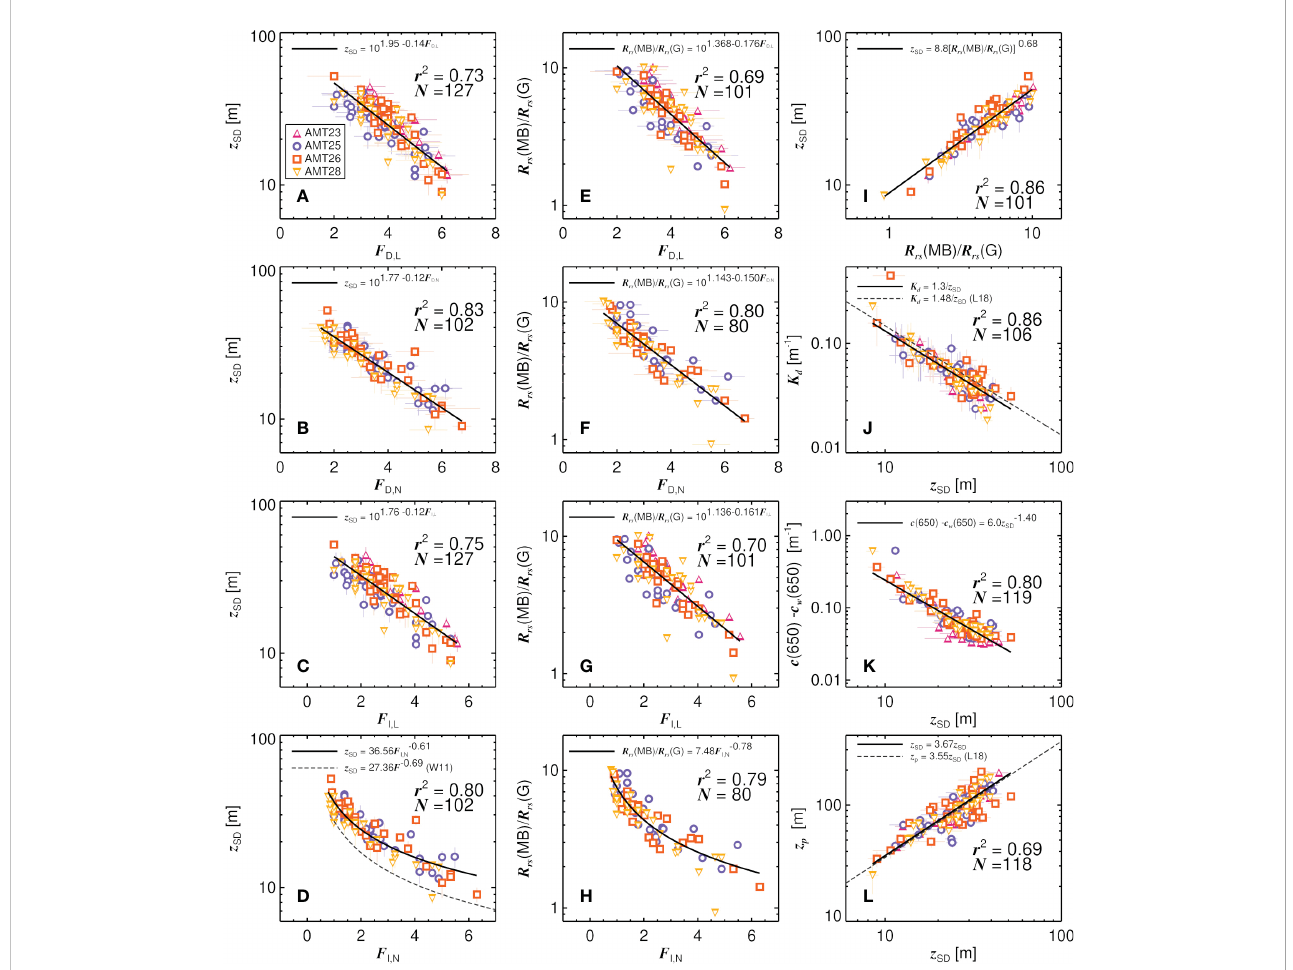
FIGURE 4 Comparison of optical measurements collected on the four AMT cruises. (A – D) Secchi depth ( z SD ) versus Forel-Ule colour ( F ), with subscripts D being colour of disk, I colour of in fi nite waters, L the LaMotte scale, and N the scale of Novoa et al. (2014). (E – H) Maximum blue-green R rs ratio ( R rs (MB)/ R rs (G)) versus Forel-Ule colour ( F ). (I) Secchi depth ( z SD ) versus R rs (MB)/ R rs (G). (J) Diffuse attenuation for PAR (10% light level, K d ) versus Secchi depth ( z SD ). (K) Beam attenuation (650 nm) ( c ) minus that of pure water ( c W ) versus Secchi depth ( z SD ). (L) Euphotic depth ( z p ) versus Secchi depth ( z SD ). Solid lines are models fi tted to the data. Dashed lines are earlier models, with W11 referring to the model of Wernand (2011) and L18 referring to models from Lee et al.